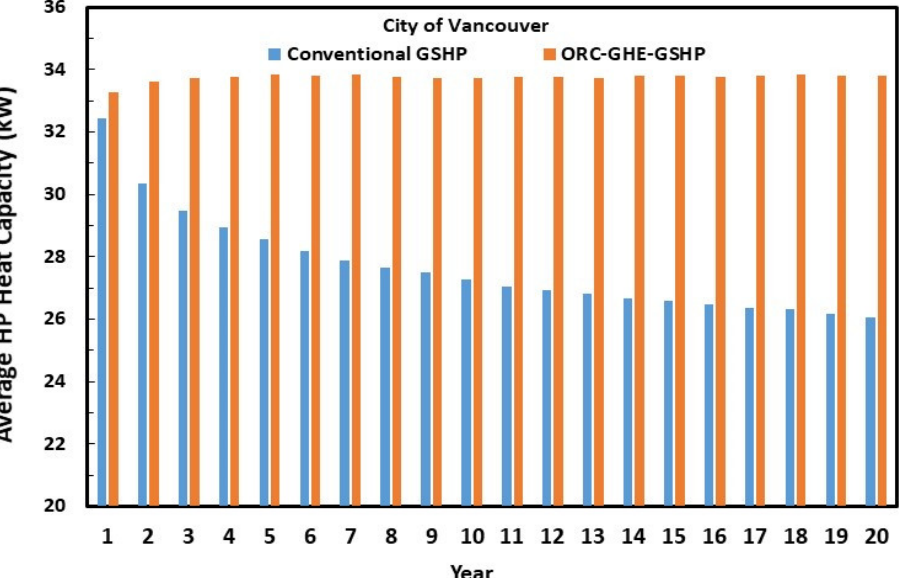
Figure 14. Average heat pump capacity during the 20-year period for the city of Vancouver and for ORC-GHE-GSHP and conventional GSHP systems.